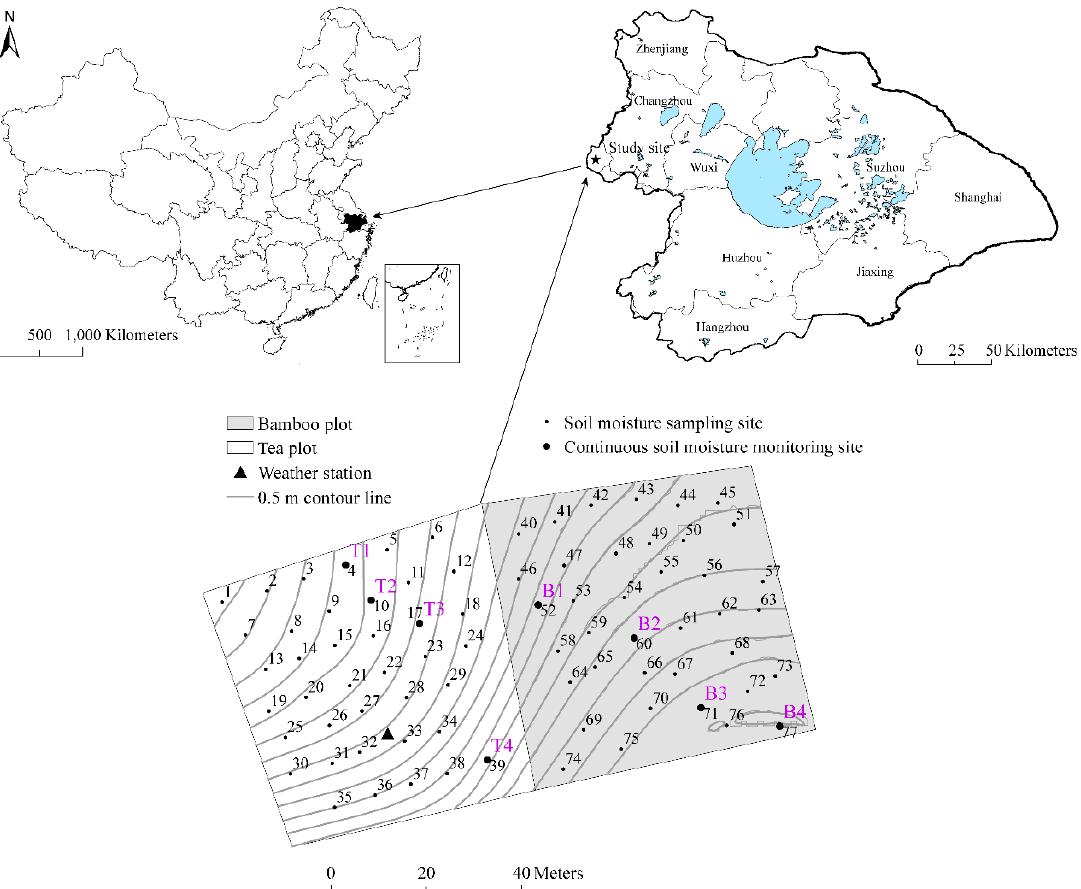
Figure 1 . Location of the study site and distribution of the sampling points for soil moisture and soil respiration.